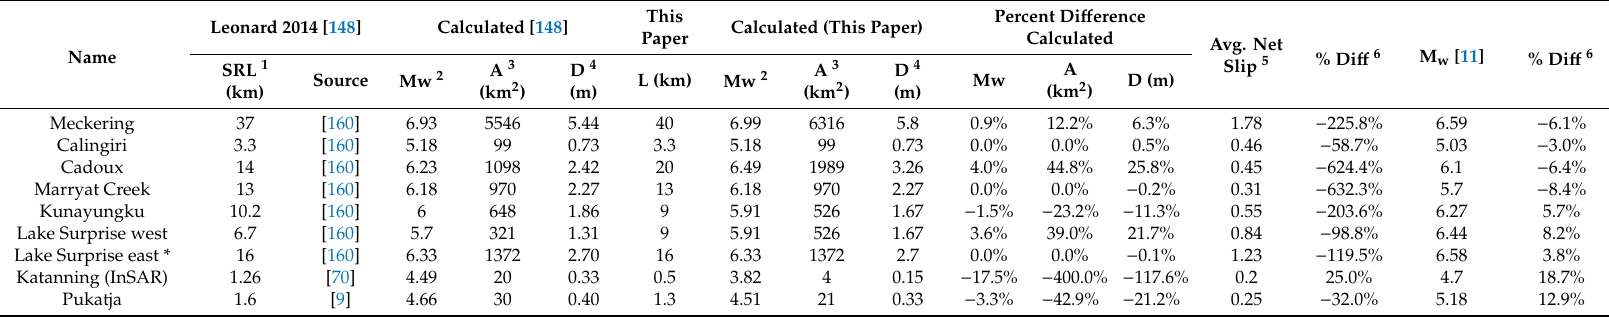
Table 10. Comparisons between calculated magnitude, area and displacement from previous length scaling relationship [148] using surface rupture length from [148] and length from this